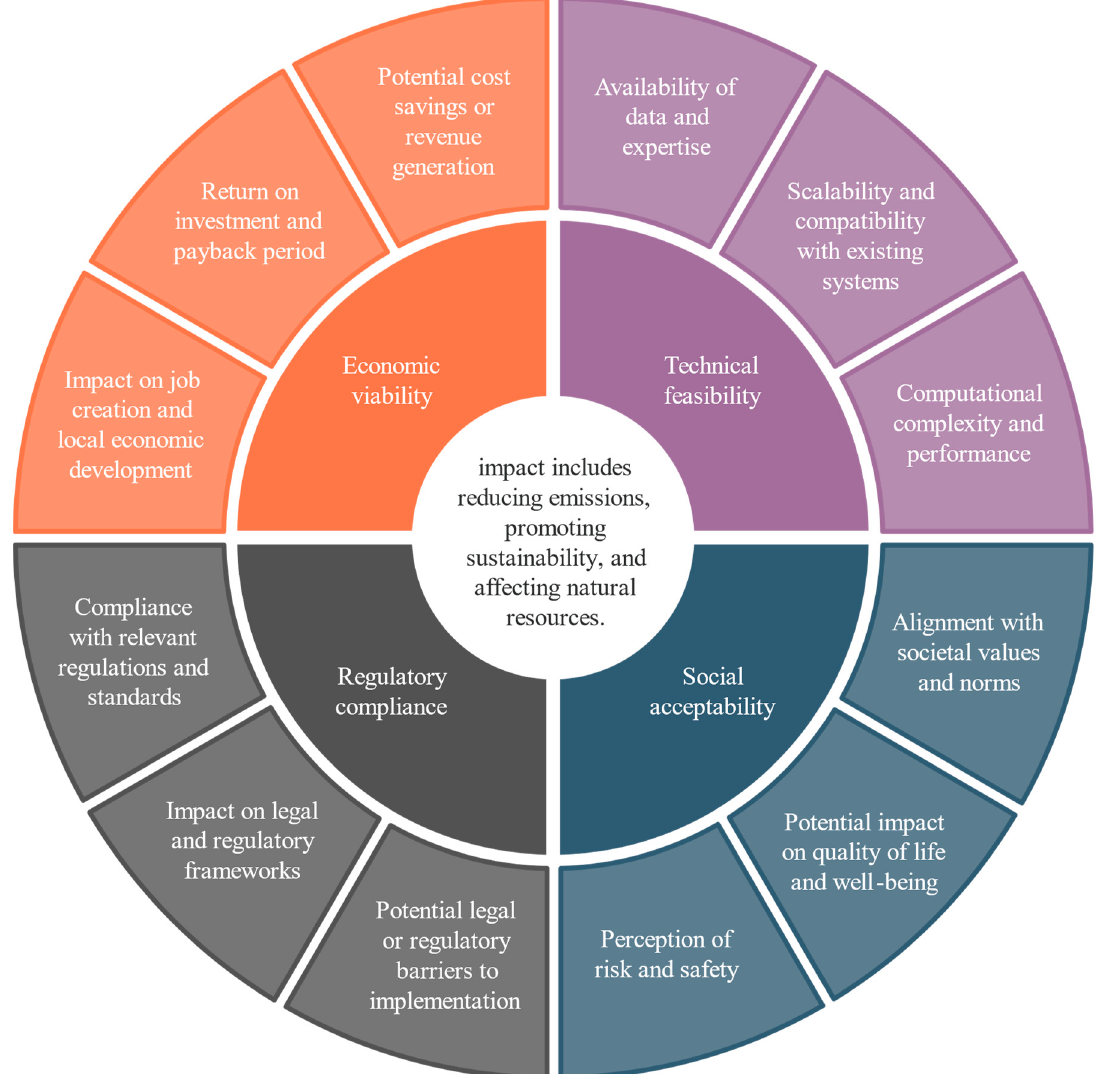
Figure 7. Evaluating criteria using sub-criteria for the five evaluation criteria, focusing on environ- mental impact.